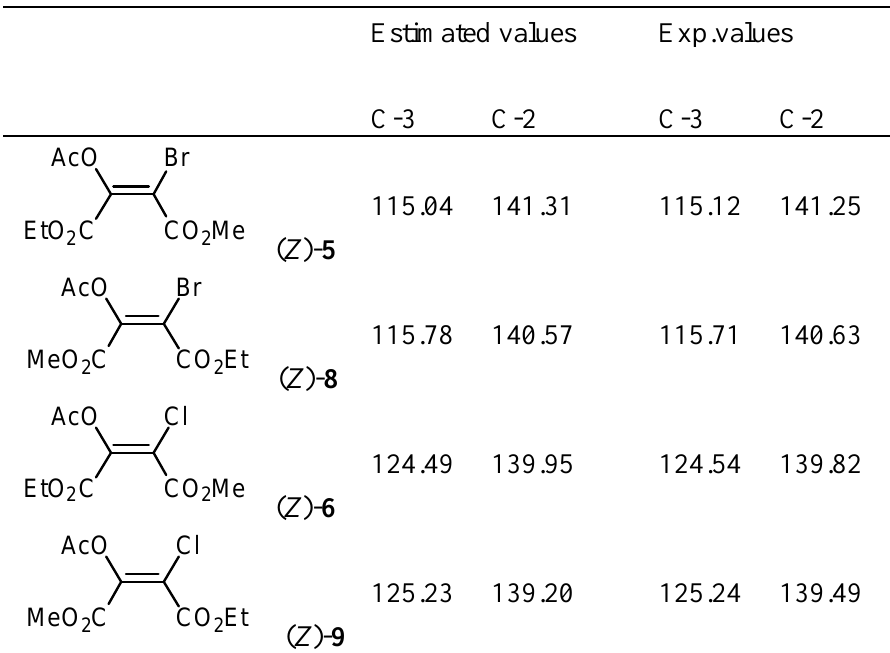
Table 4. 13 C chemical shifts